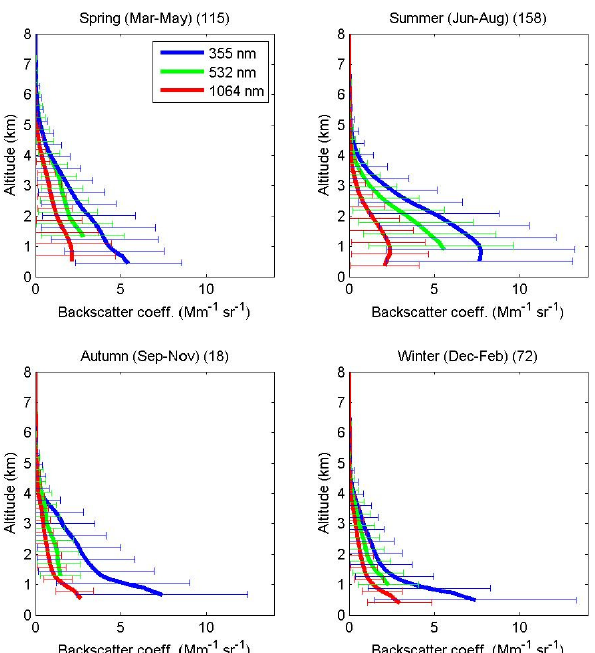
Fig. 3. Seasonal averaged backscatter profiles at three wavelengths Figure 3. Seasonal averaged backscatter profiles at three wavelengths with standard with standard deviations for the Gual Pahari site. The value in the deviations for the Gual Pahari site. The value in the plot title indicates the number of plot title indicates the number of profiles used in calculations for profiles used in calculations for each season. each season.